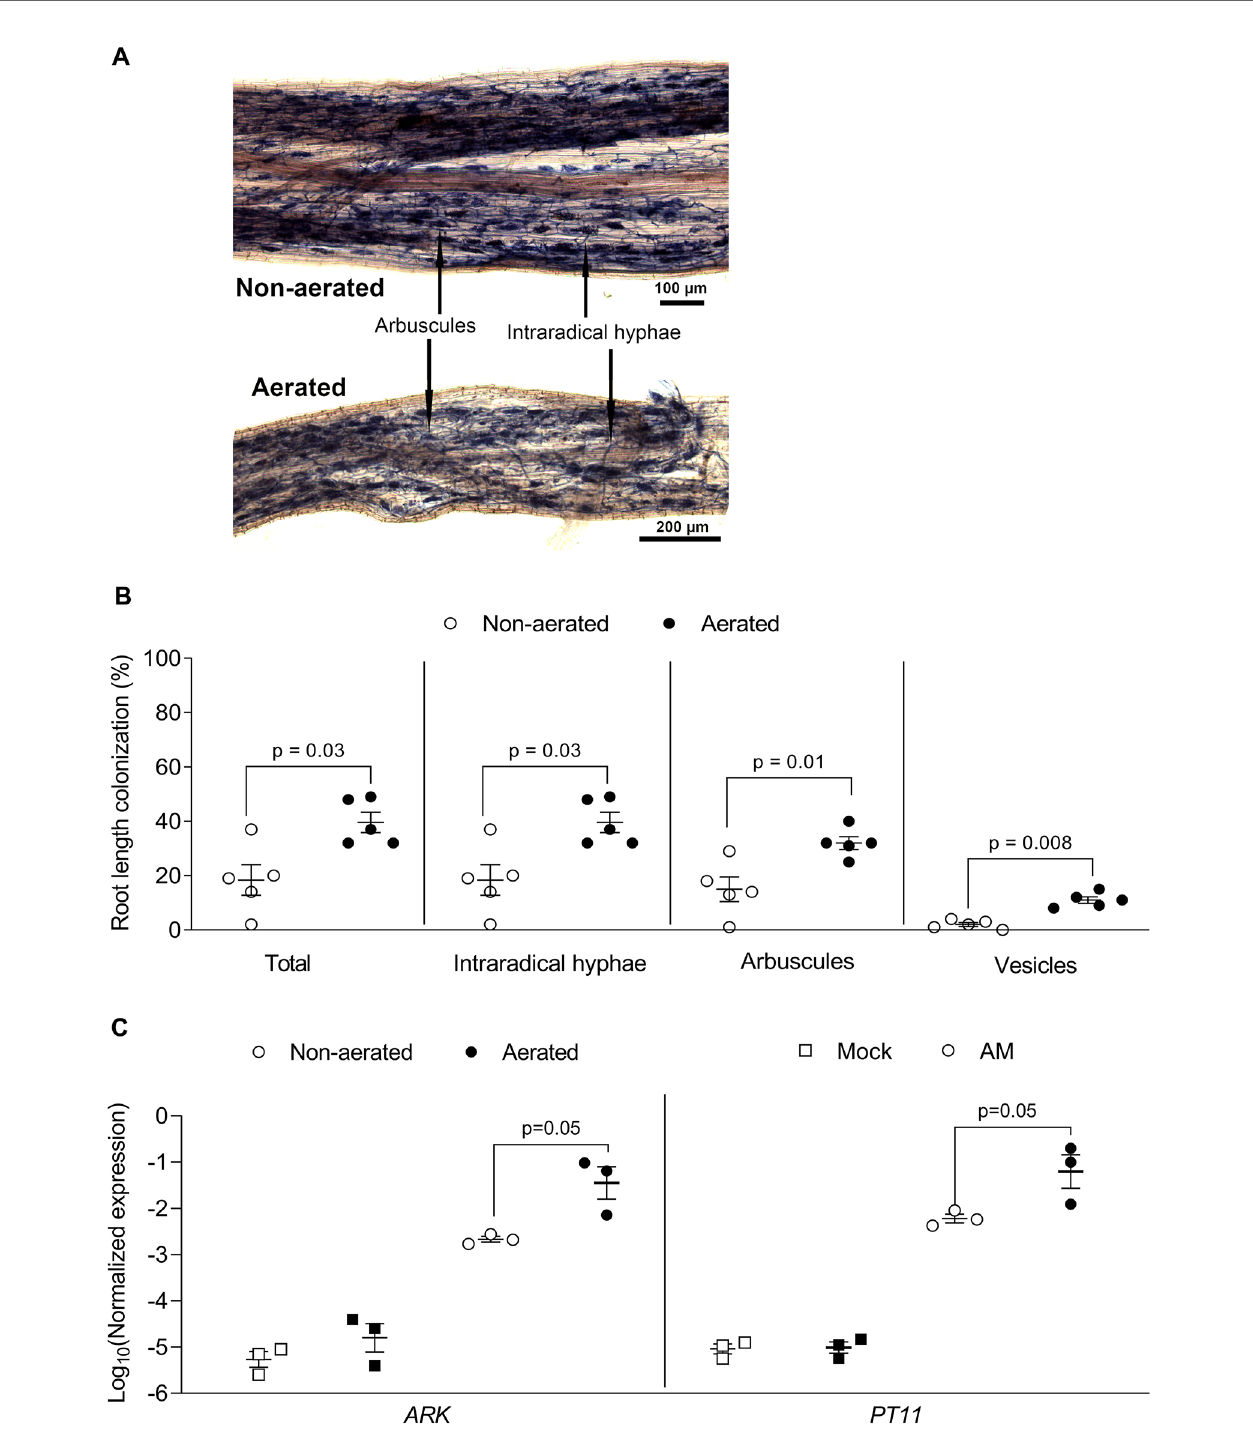
FIGURE 6 | Rice root colonization with Rhizophagus irregularis in falcon-wick hydroponics. Rice plants were inoculated with R. irregularis and grown in hydroponics for 7 weeks before harvest and analysis. (A) Representative images of rice roots colonized with R. irregularis and grown in non-aerated and aerated hydroponics. (B) Percent root length colonization for different arbuscular mycorrhiza fungi (AMF) structures in rice roots grown in non-aerated and aerated hydroponics (statistics: Mann-Whitney test, n = 5 separate plants grown in one bucket). (C) Effect of aeration on AM marker gene expression as determined by quantitative PCR (qPCR). The expression value was of ARK and PT11 was normalized to the expression value of the constitutively expressed gene CYCLOPHILLIN2 (statistics: Mann-Whitney test, n = 3 independent root systems per treatment).